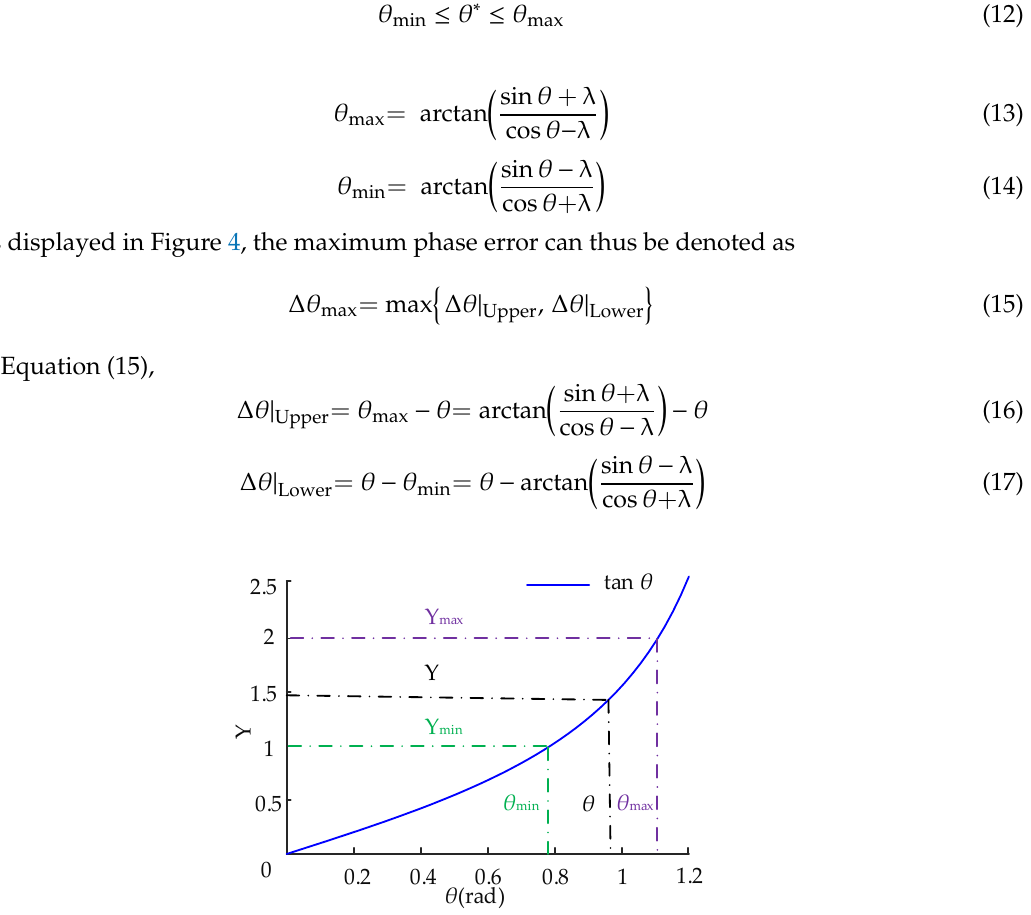
Figure 4. The calculation error analysis of voltages phase under random noise interference.